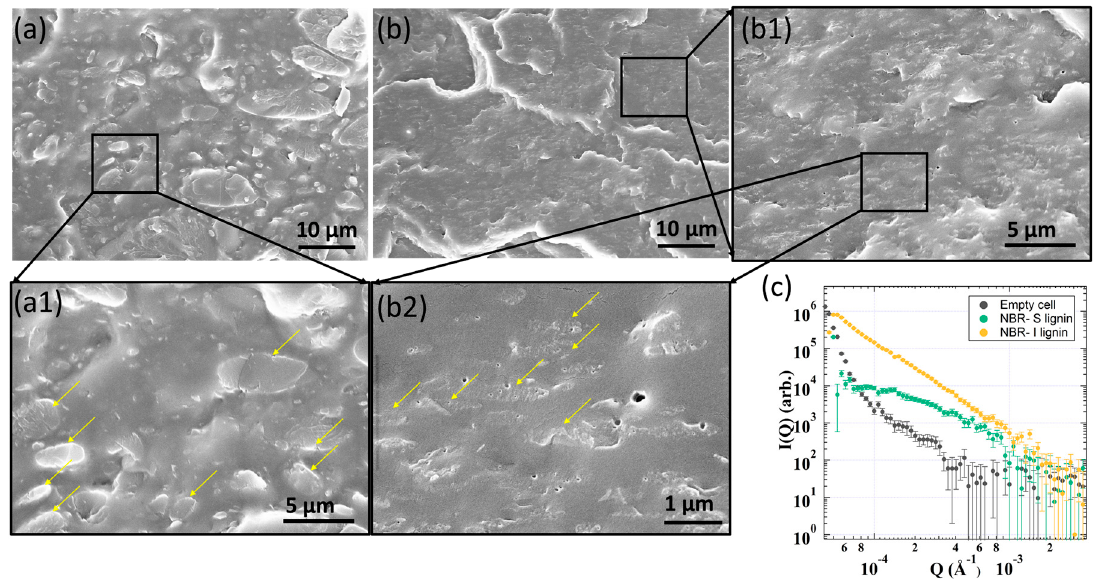
Figure 5. Morphological characteristics of 50 wt.% NBR-S lignin / I lignin samples: ( a,b ) SEM data of 50 wt.% NBR-I lignin and 50 wt.% NBR-S lignin, respectively. ( a1 , b1 , b2 ) high resolution SEM images of the corresponding samples; ( c ) USANS of NBR-I lignin and NBR-S lignin samples.